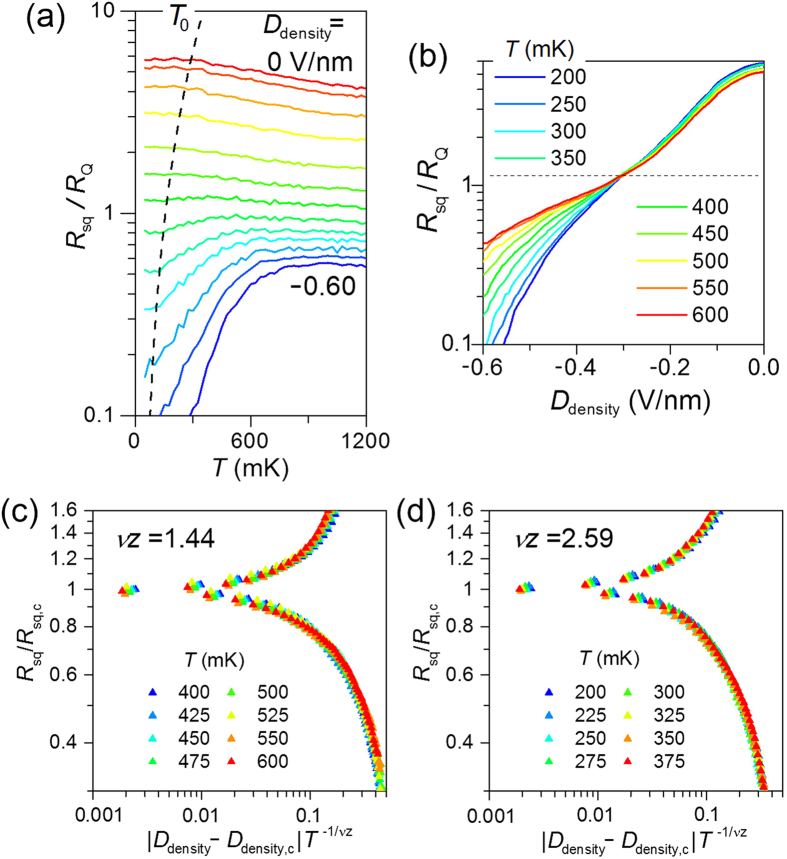
Temperature dependence of square resistance and its scaling behavior.(a) Temperature dependence of the square resistance Rsq with various Ddensity for a fixed Dgap = −0.86 Vnm−1 plotted with a log-linear axis. Ddensity was varied in steps of 0.05 Vnm−1 from 0 Vnm−1 (top) to −0.60 Vnm−1 (bottom). The broken curve indicates the heating-induced crossover temperature T0, below which the electron temperature and Rsq saturated. (b) The data set in (a) plotted as a function of Ddensity at various T. The horizontal broken line indicates the point of convergence. Finite-size scaling analysis of the Ddensity-driven superconductor–insulator transition for sweep 2 in Fig. 2(a). For 400 < T < 600 mK (c), vz = 1.44 gave the best data collapse; however, for temperatures of 200 < T < 375 mK (d), vz = 2.59 resulted in the best data collapse.